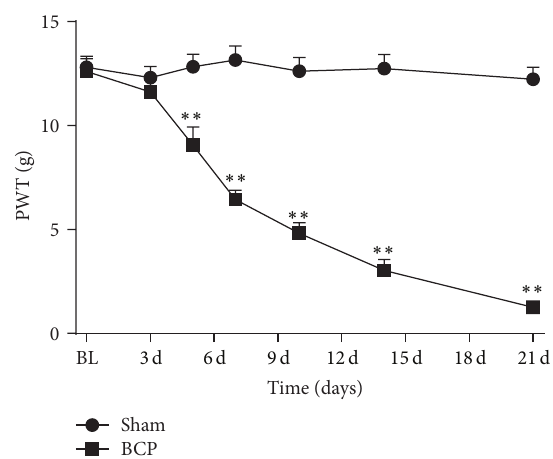
Figure 1: Rats with tibia tumors after Walker 256 cells inoculation displayed mechanical allodynia. The PWT progressively decreased on days 5, 7, 10, 14, and 21 ( 𝑛 = 10 ) after inoculation in BCP group compared with sham group. Results are given as means ± SEM. ∗ 𝑃 < 0.05 , ∗∗ 𝑃 < 0.01 versus sham